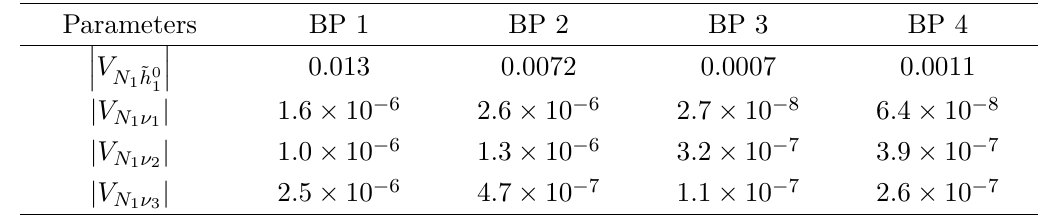
Table 4 . Estimated magnitudes of the pseudo-Goldstone fermion’s mixing with Higgsino and light neutrinos for the benchmark